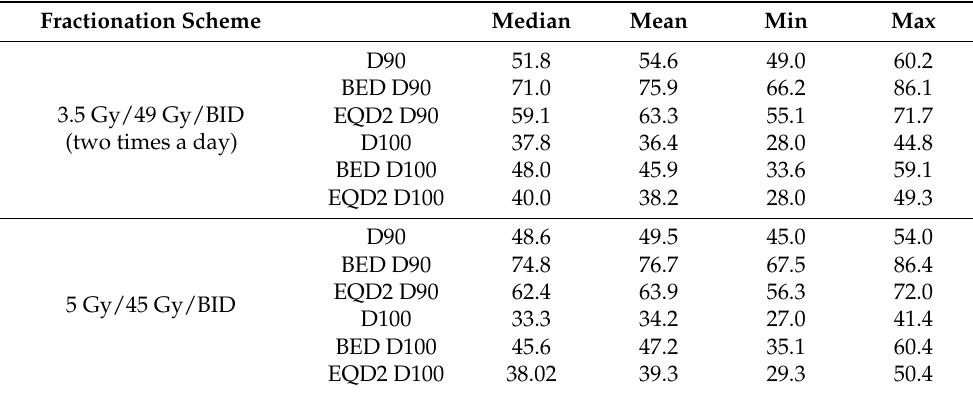
Table 2. Characteristics of treatment schemes and dosage.